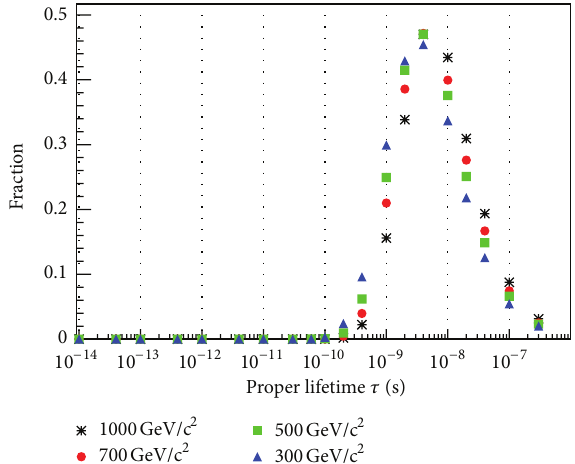
Figure 9: Fraction of decays of heavy quarks between the accep- tance of the displaced vertex analysis and HSCP